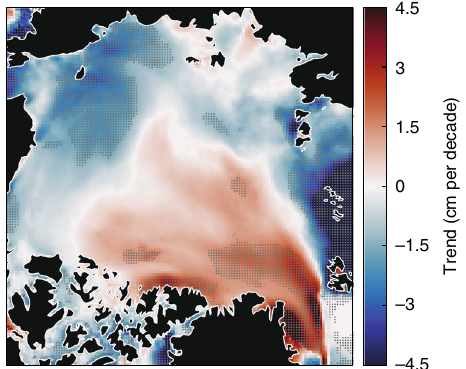
Fig. 9 The trend in snow depth (centimeters per decade) for the 1980 – 2016 March/April average. March and April were selected since they represent the annual snow depth maximum for the majority of Arctic sea ice. The dots indicate areas with at least 95% statistical signi fi